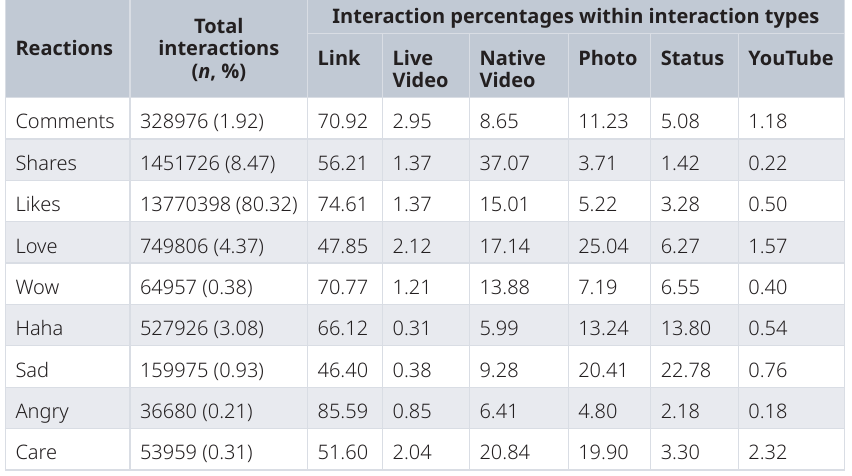
Table 3. Interaction numbers and their percentages within the interaction